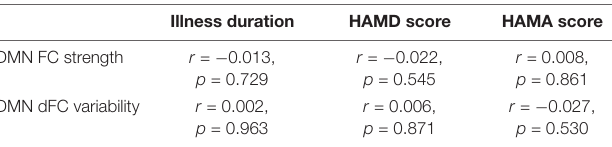
TABLE 4 | Correlations between the DMN FC/dFC and clinical characteristics.